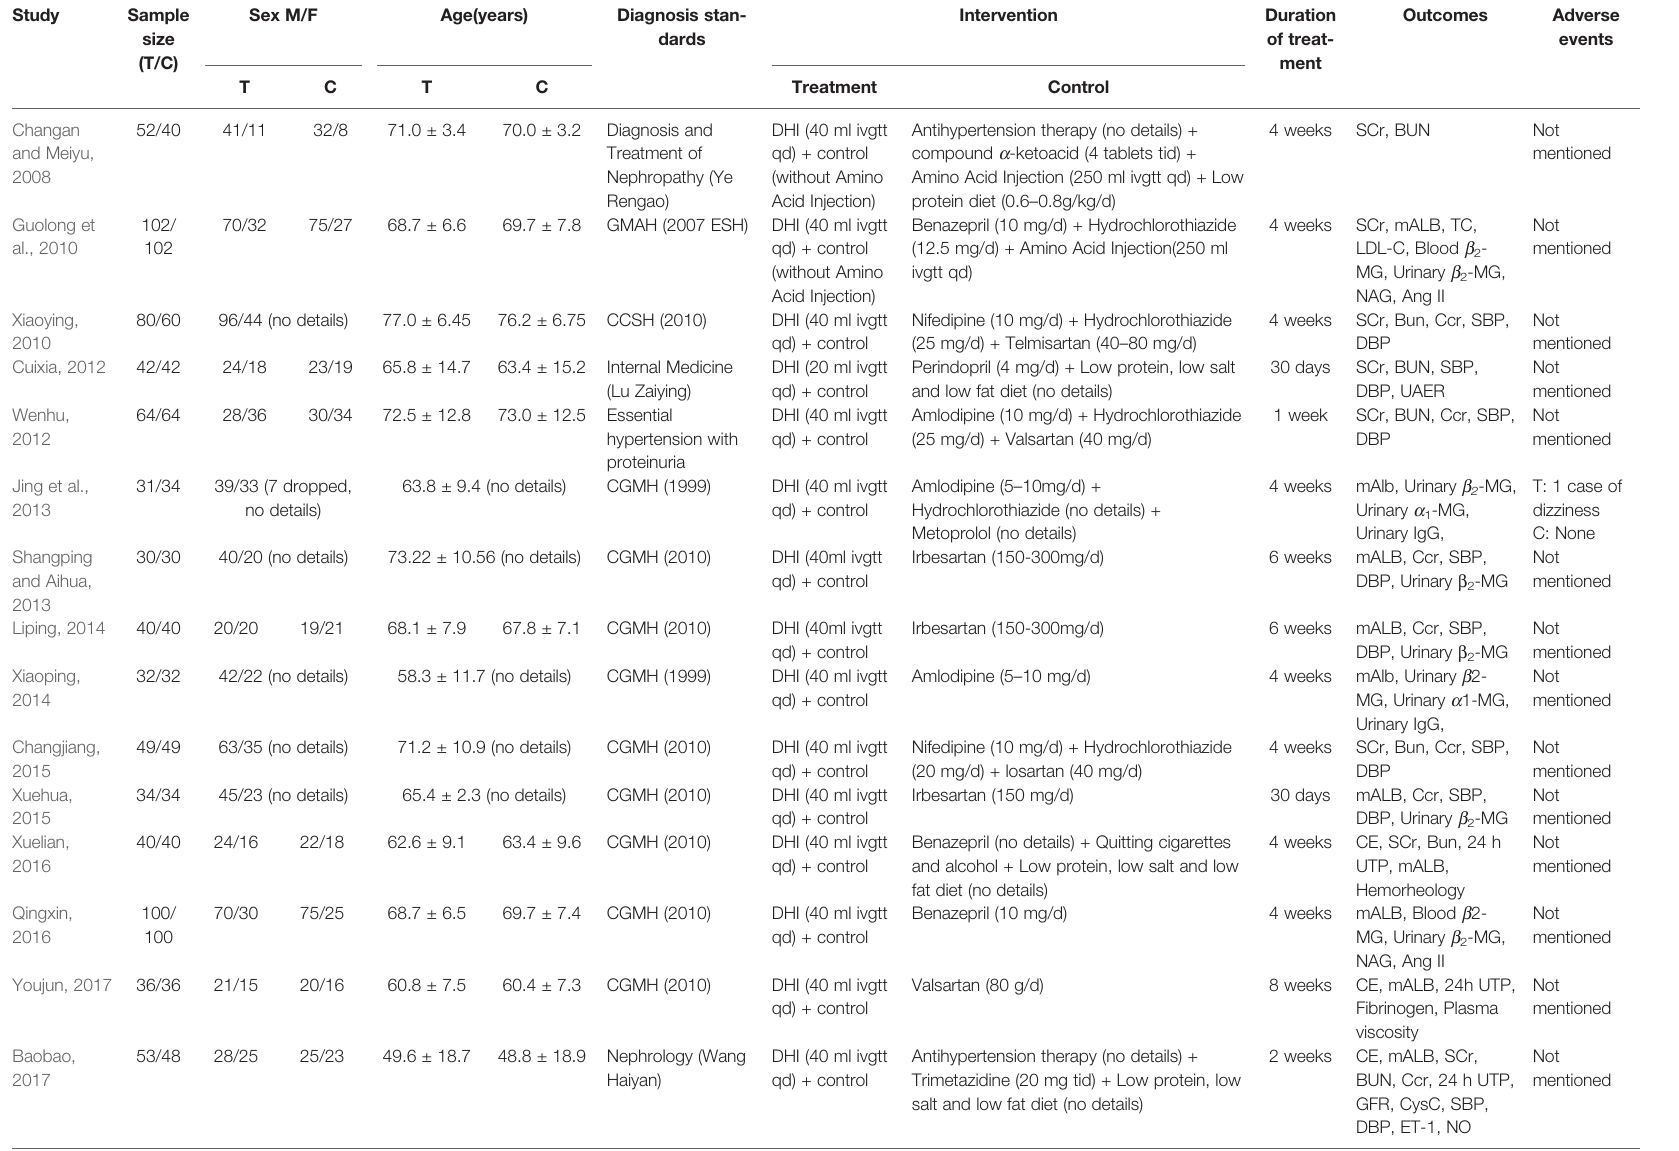
TABLE 1 | Characteristics of the included